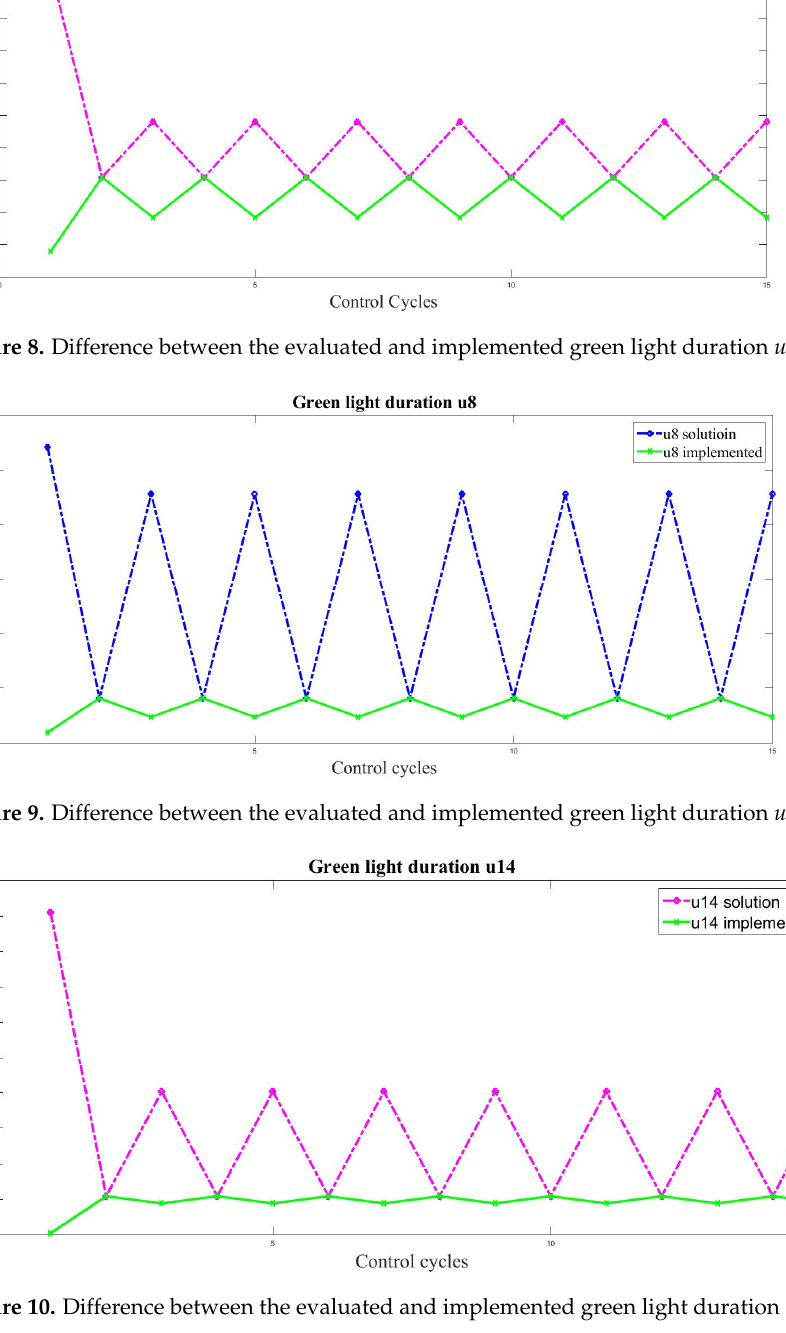
Figure 10. Difference between the evaluated and implemented green light duration u 14 .